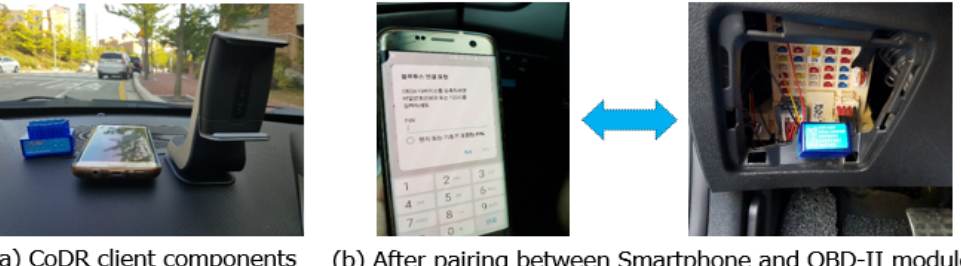
Figure 2. CoDR client: ( a ) main components and ( b ) after completing Bluetooth pairing between smartphone and OBD-II module in a